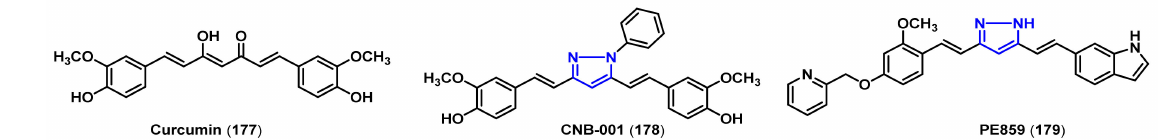
Figure 11. Chemical structures of pyrazole-containing curcumin derivatives.